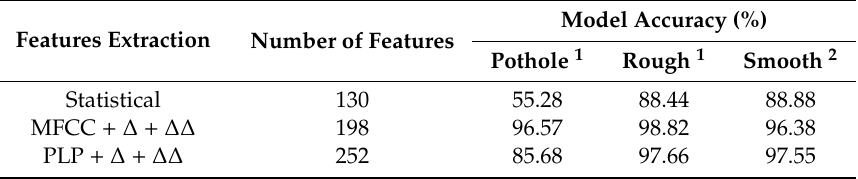
Table 6. Results from di ff erent road conditions.